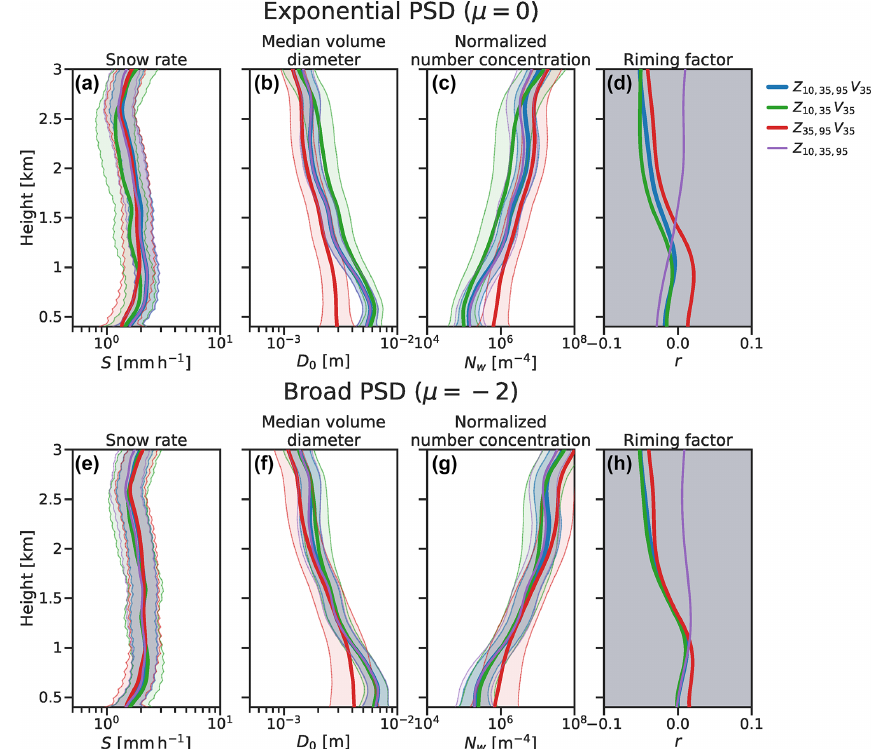
Figure A2. Profiles of retrieved variables for retrievals of a selected profile during the unrimed snow regime. Retrievals assuming (a–b) an exponential PSD are compared against those with (e–h) a broad PSD with µ = −